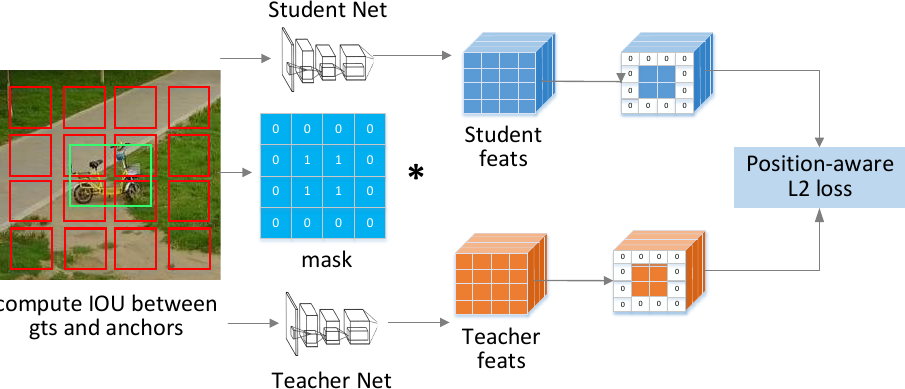
Figure 5. The Adaptive Key Distillation Positions (AKDP) Algorithm for anchor-based feature map distillation. In the first step, feature mask is computed based on the IOU between the preset anchors and true bounding boxes, which indicates the attention area in both teacher’s and student’s feature map. Then, the position-aware L2 distance is used to measure the gap between the teacher-network and